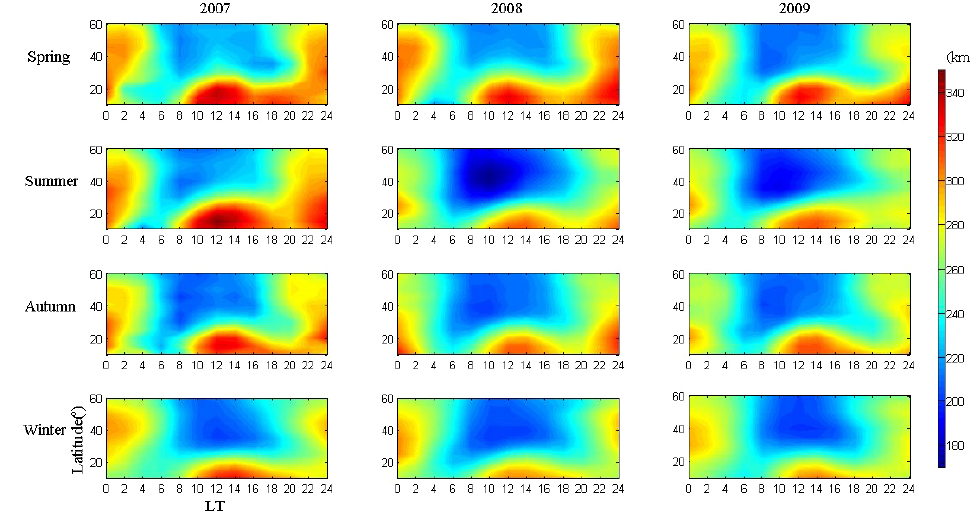
Figure 6. Latitudinal, diurnal and seasonal variation in Hm F2 during the low-solar-activity period of 2007–2009.